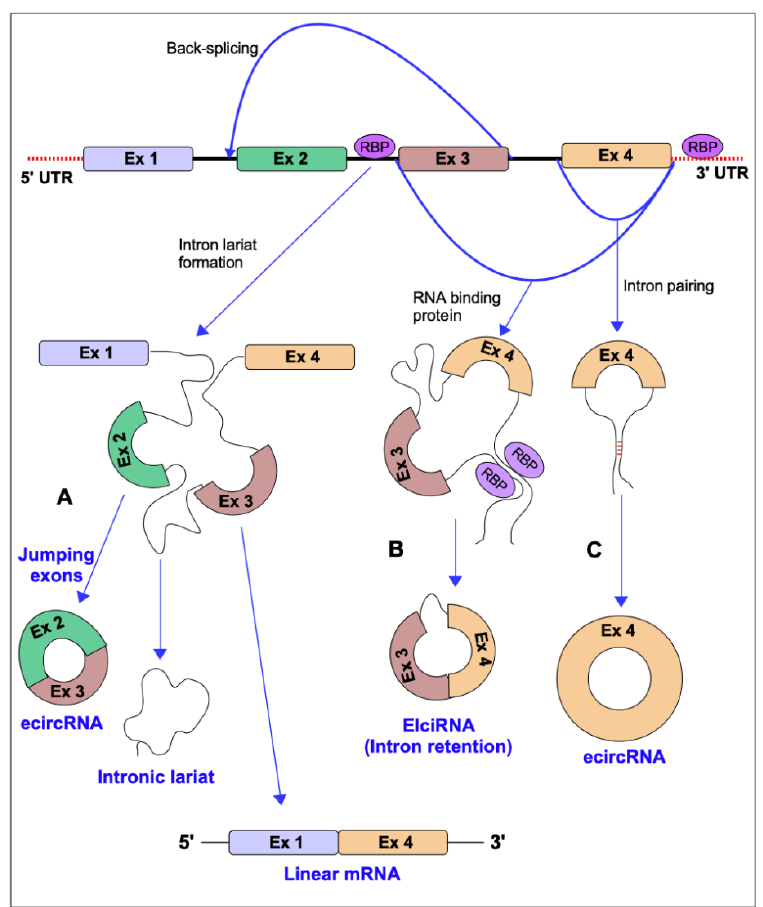
Figure 1. The circular RNA (circRNAs) biogenesis. Three mechanisms that lead to circRNA biogenesis are briefly described in the picture. ( A ) The first mechanism causes exon skipping and intron lariat production. “Jumping exons” consist of bringing together two distant exons with the formation of intron circular lariat. The lariat formation allows for the circularization of the “skipped” exons. Three different types of RNA molecules are produced: circRNA, intron lariat, and linear mRNA containing skipping exons. ( B ) The second mechanism is regulated by RNA-binding proteins, which bind the neighboring introns of the exon that should circularize and create an RNA loop when RBPs dimerize. The link between 3′ and 5′ ends of the circularized exons can facilitate splicing. ( C ) In the third mechanism, the circularization of the exon/exons is promoted by the complementary pairing of the flanking introns. Pairing with a complementary inverted sequence, such as ALU repeats, could increase back-splicing.